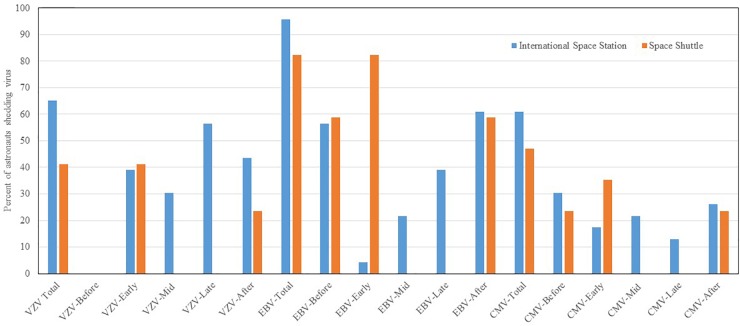
Percent distribution of astronauts shedding VZV. EBV and CMV before, during the mission at time point early-mission, mid-mission, late-mission, and after either short and long duration space flights. Saliva and urine samples were collected from 112 astronauts (89 short duration and 23 long duration) before, during, and after the spaceflight. Saliva was analyzed for Epstein–Barr virus (EBV) and varicella-zoster virus (VZV), and urine was analyzed for Cytomegalovirus CMV by real time PCR assay using Taqman 7900 (Thermofisher, Inc.). The shedding of EBV. VZV and CMV DNA in body fluids is significantly higher during spaceflight as compared to pre-flight, post-flight, and the control p < 0.01 (Mehta et al., 2014, 2017). However, when comparing these shedding patterns between space shuttle and ISS missions, the differences were not significant.